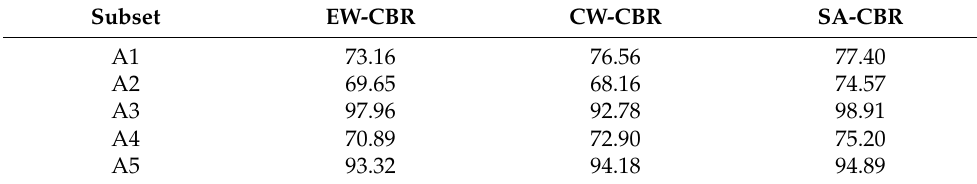
Table 7. State classification accuracy rate